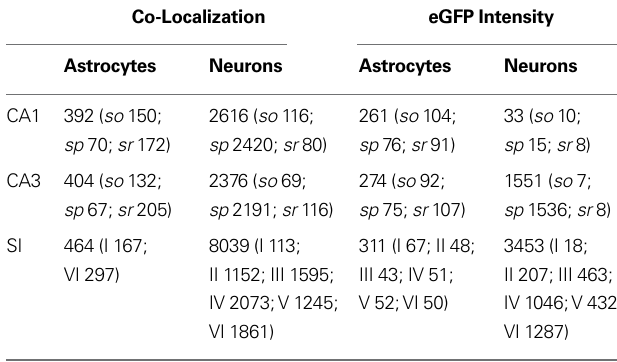
Table 1 | Number of cells studied in co-localization and eGFP intensity